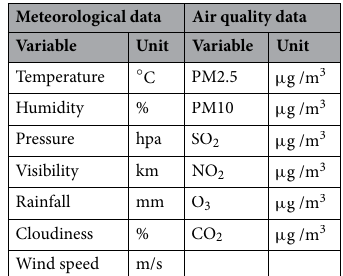
Table 2. Candidate variables used to predict AQI.